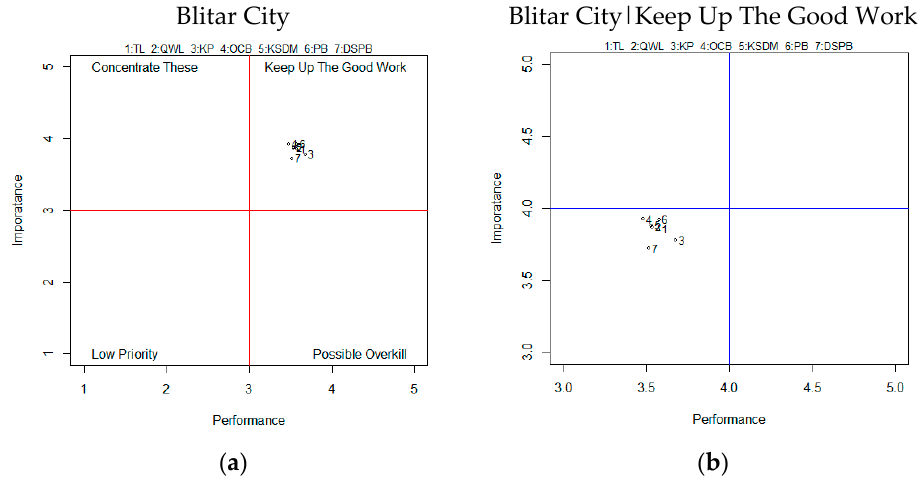
Figure 10. ( a ) IPA Cartesian Diagram of Blitar City. ( b ) IPA Cartesian Diagram of Keep up the Good Work Quadrant of Blitar City.